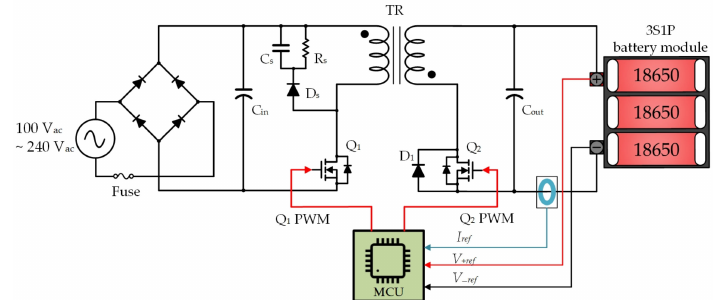
Figure 1. Schematic diagram of the DSBFC.